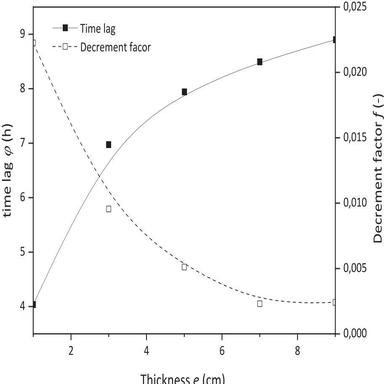
Thermal performance of the hybrid wall according to the thickness of the COP40.